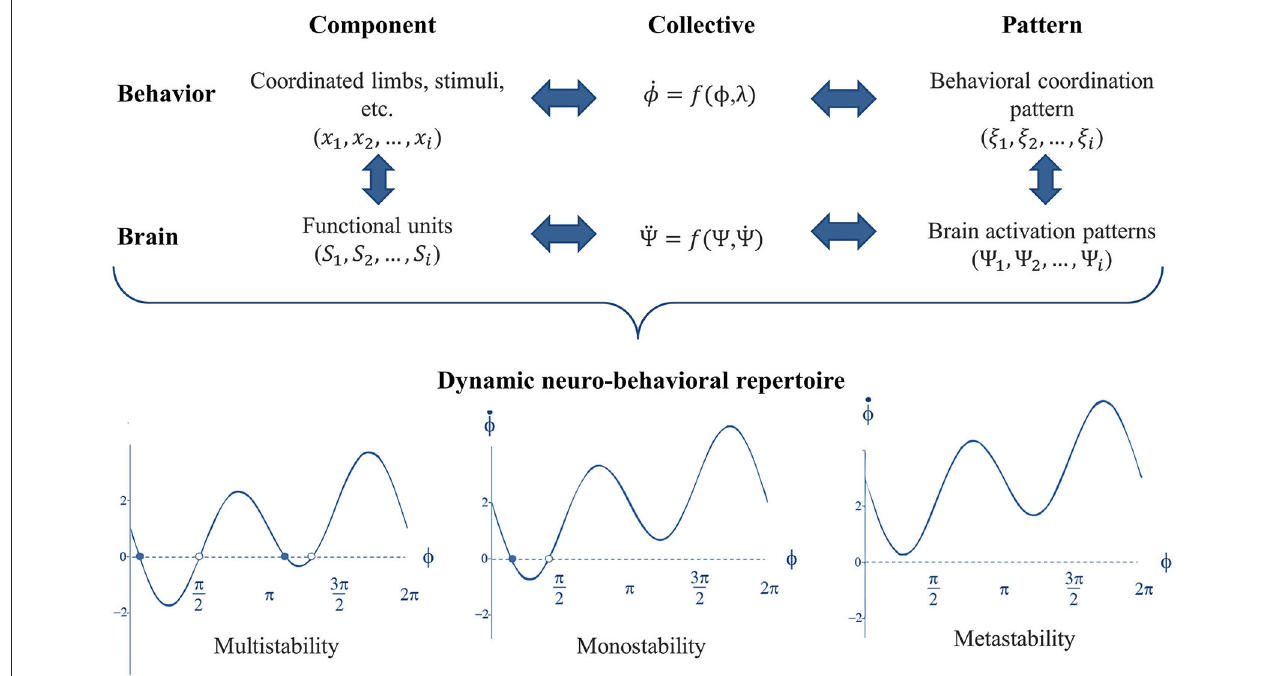
possesses a dynamic repertoire of attractor states, in which multiple stable attractors can coexist (multistability) or not (monostability). Attractors can also be virtually present as “ghost attractors” giving rise to both phase trapping and phase scattering dynamical flows